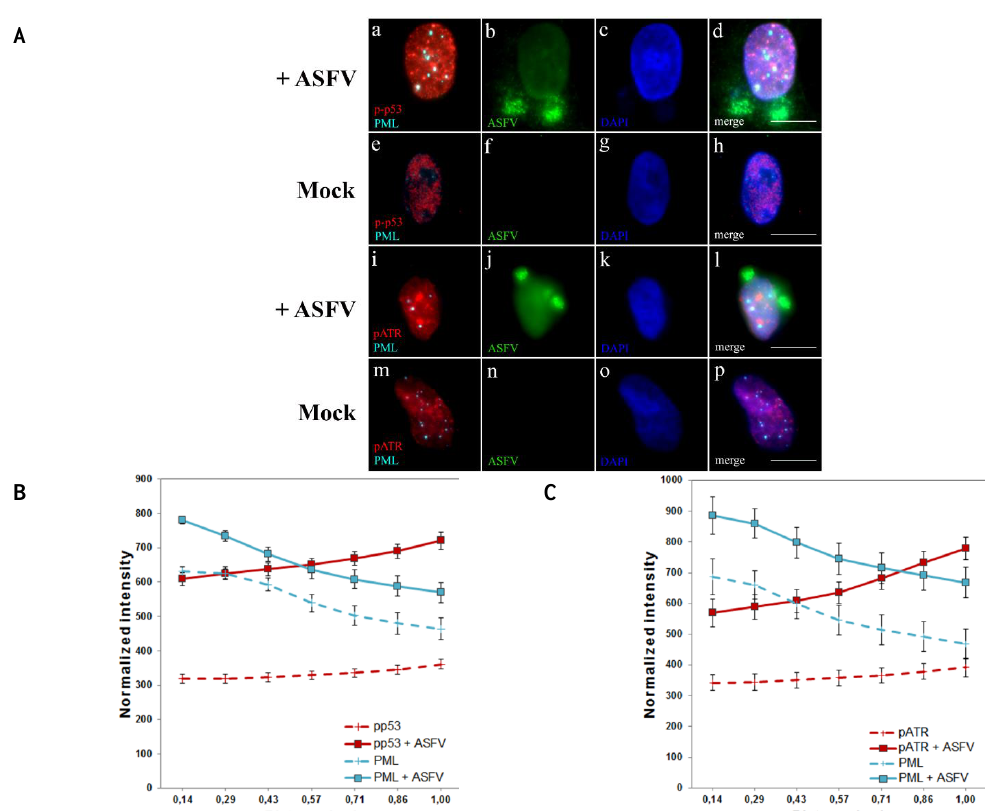
Figure 2. PML-NBs and DDR factors juxtapose during ASFV infection. ( A ) Immunofluorescence analysis of PML-NBs (cyan) and two DNA damage response factors (red) was performed in ASFV-infected cells (8 hpi, green) and in non-infected cells. Cell nuclei were counterstained with DAPI (blue). ( a – d ) In ASFV-infected cells, enlarged PML-NBs (cyan) are juxtaposed to phosphorylated p53 form (p-p53, red), while in non-infected cells these subnuclear domains do not associate to activated p53 loci ( e – h ). Additionally, enlarged PML-NBs neighbour pATR accumulations ( i – l ), as non-infected cells display smaller PML-NBs and pATR faint staining dispersed throughout the nucleus ( m – p ). Scale bar, 10 μm. Representative microscopy images of at least three independent experiments are shown; ( B ) and ( C ) Relative distance between PML-NBs and p-p53/pATR foci was evaluated by radial intensity profile analysis in ASFV-infected cells (solid lines) and non-infected cells (dashed lines). Normalized fluorescence intensity curves from the centre of PML-NBs (blue lines) to p-p53 accumulations (B) or to pATR foci (C) (represented by red lines) are plotted. Error bars represent standard errors (±SE). Radial profile analysis shows the close proximity between the subnuclear domains and the higher intensity DDR-factor accumulation regions only in ASFV-infected cells, as blue and red solid lines cross at a point of the studied radius, contrasting to the absence of intersection between PML-NBs (blue dashed lines) and p-p53/pATR fluorescence intensities (red dashed lines) in non-infected cells.